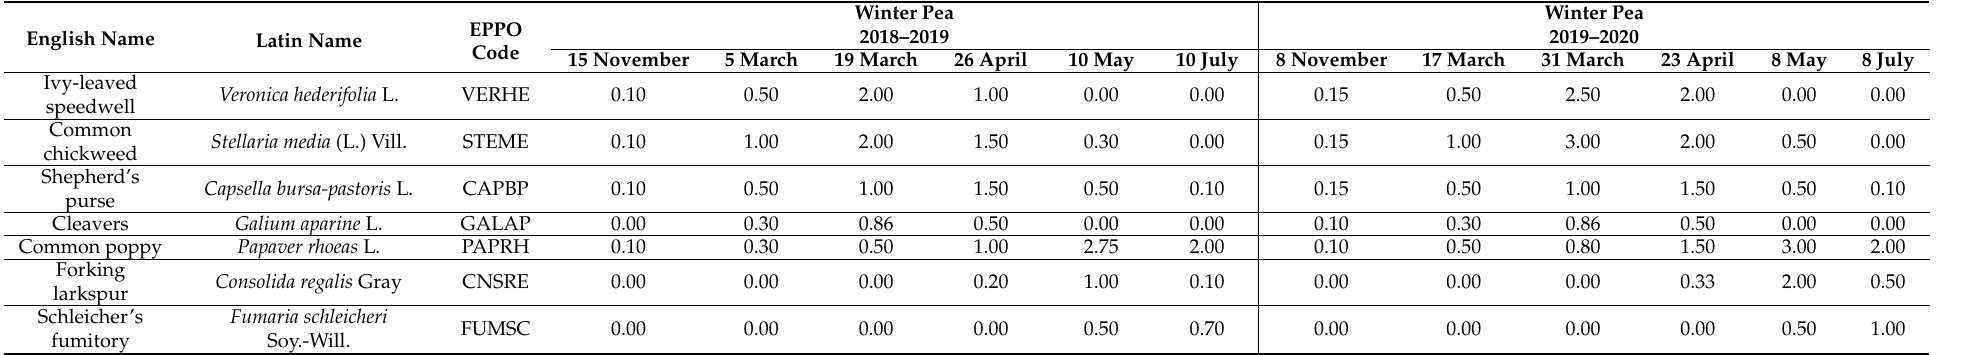
Table 5. Weed cover (%) of pure winter pea ( Pisum sativum L.) without weed management in control plots (2018/2019 and